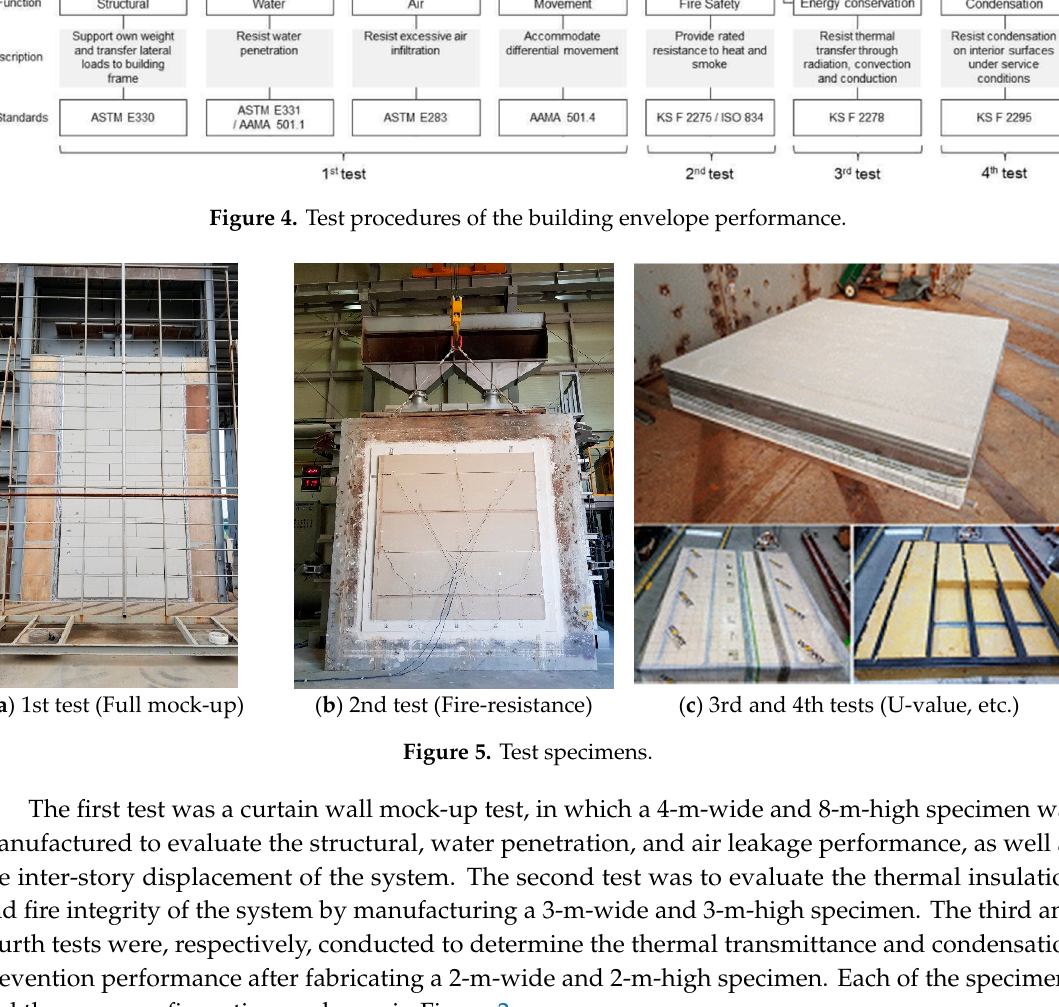
Table 1. Results of the curtain wall mock-up test.